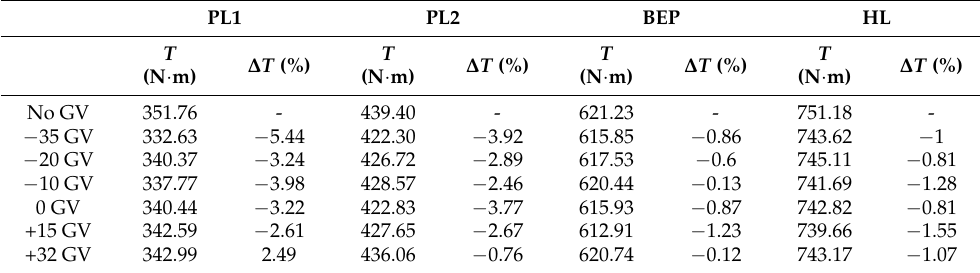
Table A3. Generator torque (T) and difference ( ∆ T) without and with the GV system.